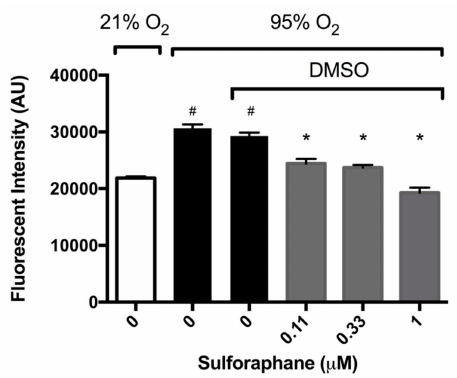
Figure 3. Sulforaphane (SFN) reduces intracellular ROS. RAW 264.7 cells were incubated with varying concentrations of SFN (diluted in DMSO as the vehicle) and exposed to hyperoxia for 24 h. Following hyperoxia exposure, cells were incubated with 2 (cid:48) ,7 (cid:48) –dichlorofluorescin diacetate (DCFH-DA) for 30 min at 37 ◦ C. Fluorescence was determined using a microplate reader (Excitation / Emission = 485 / 535 nm). Each bar represents the mean ± SEM of fluorescence for two independent experiments. # p < 0.05 compared to 21% O 2 control group. * p < 0.05 compared to 0 µ M SFN vehicle control group.